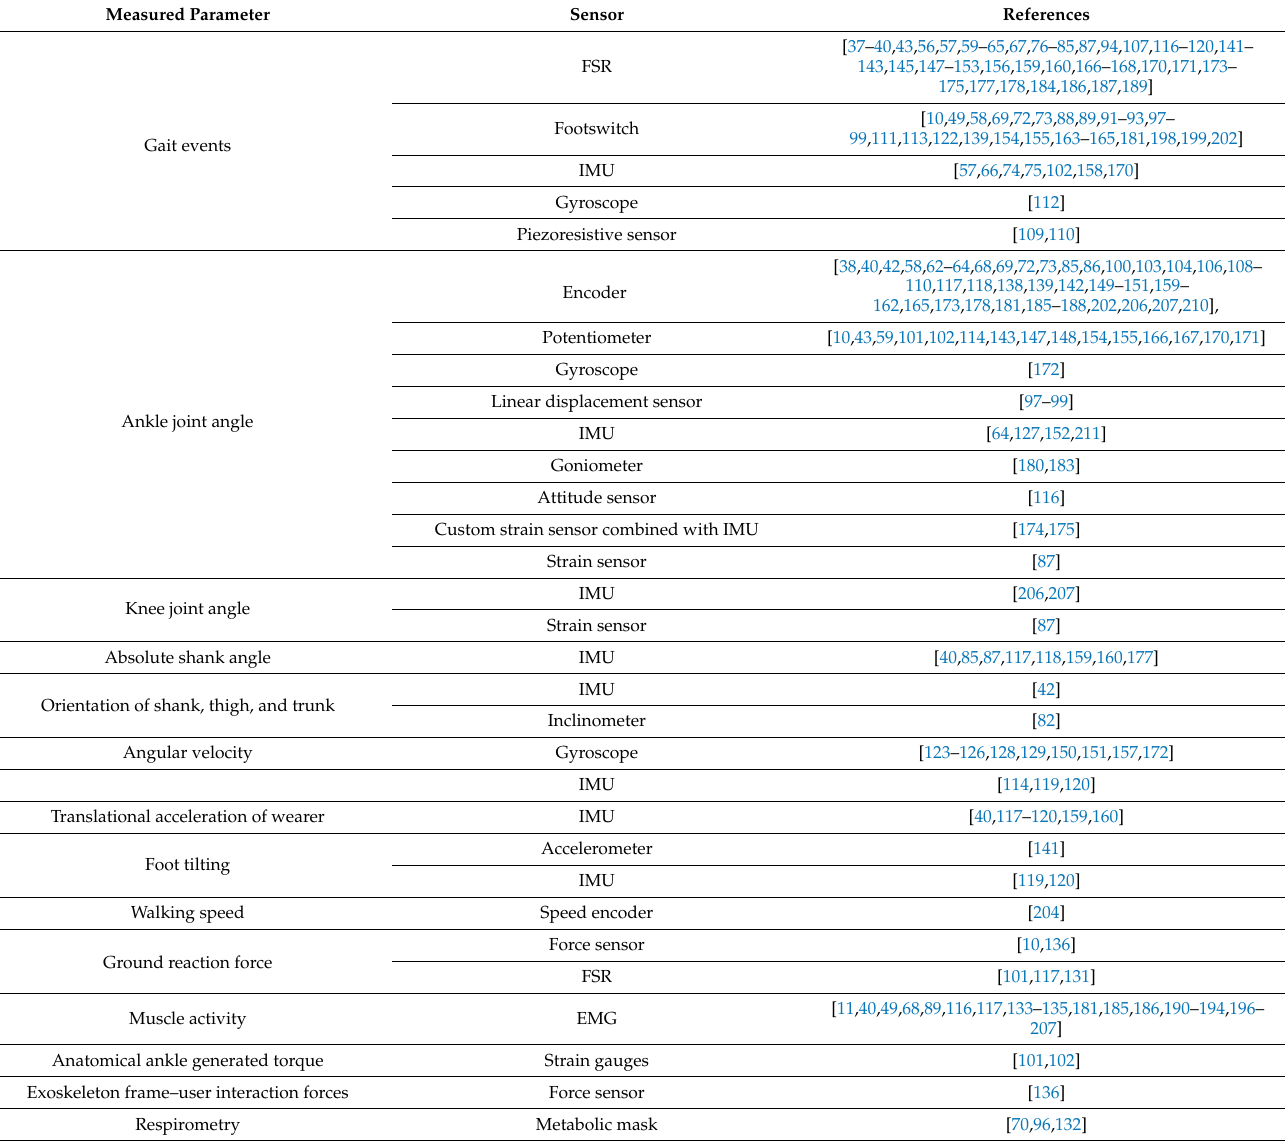
Table 3. Parameters measured from the human user by human–machine interface sensors as reported by the reviewed PAEs. Different sensor types employed for measuring each parameter and their corresponding references are provided in the second and third columns,